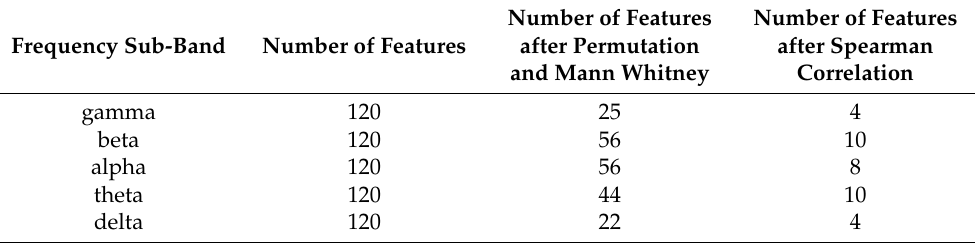
Table 2. The number of features after applying feature selection